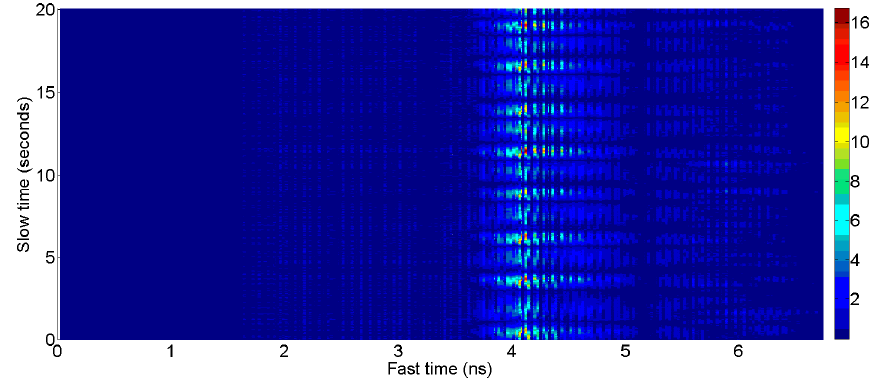
Figure 2. “Vital signal” vs slow time and fast time.